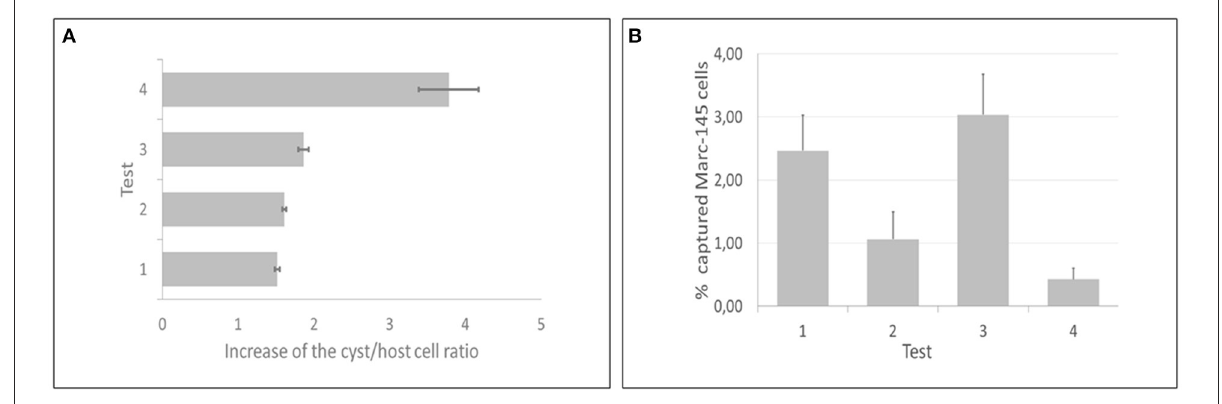
FIGURE5 Direct and indirect immunomagnetic separation methods for in vitro produced cysts of Toxoplasma gondii were each tested at two reaction temperatures (4 and 24 ◦ C). (A) Test 4 (indirect capture at 24 ◦ C) presented the best performance, as the cyst/host cell ratio had a maximum increase of 3.78 times. (B) Test 3 (indirect capture at 4 ◦ C) showed the highest non-specific binding, contrasting with test 4, that showed the lowest non-specific binding.